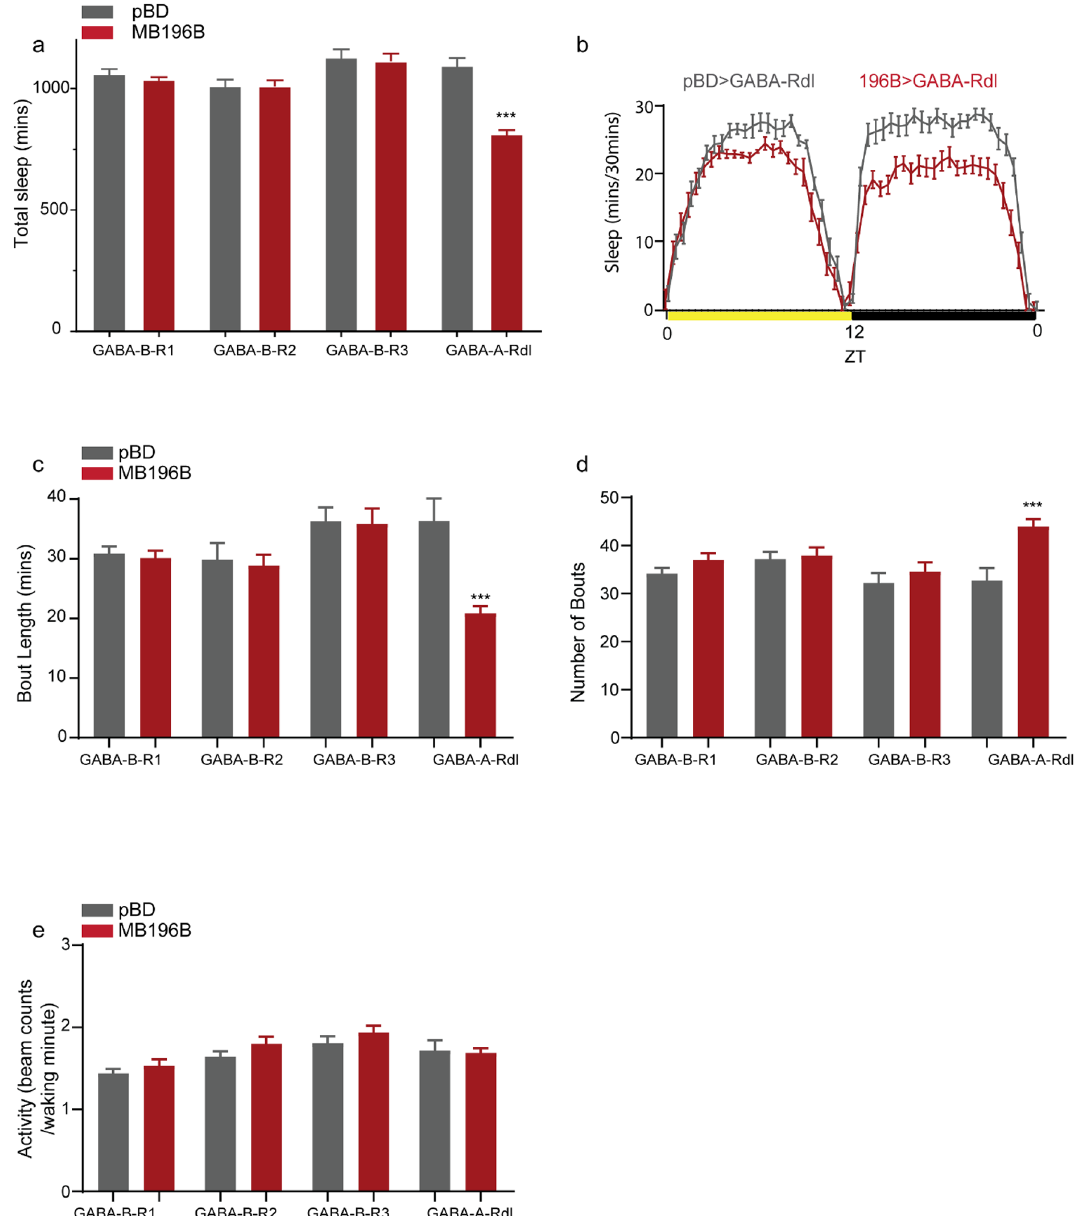
Figure 2. PAM-DAN mediated wakefulness is inhibited by GABA and GABA A Rdl receptor expression. RNAi lines targeting GABA A and GABA B receptors were expressed in PAM-DANs targeted by MB196B or control (empty split-GAL4/pBD) and sleep was measured using Drosophila Activity Monitoring system. Sleep data represents 2-day average after 2-days of 12 h light and 12 h. dark entrainment. ( a ) Total sleep or sleep duration over 24 h in flies expressing validated RNAi lines targeting one of the GABA B (R1, R2 and R3) or GABA A (Rdl-Resistance to dieldrin) receptor or subunits in wake-promoting PAM-DANs (MB196B: red) and enhancerless/empty-GAL4 (pBD: grey) in the same genetic background. Significant differences were detected between MB196B and pBD driver lines expressing UAS-RNAi targeting GABA A Rdl receptor. ( b ) Representative sleep profile of RNAi mediated depletion of ionotropic GABA A Rdl receptors in PAM MB196B (red) and empty/enhancerless-GAL4 control (grey). ZT indicates zeitgeber time where ZT 0: lights on and ZT 12: lights off. ( c , d ) Average bout length (minutes) and average number of bouts. Significant differences were detected between MB196B and pBD driver lines expressing UAS-RNAi targeting GABA A Rdl receptor. ( e ) Activity or average beam crossings/waking minute indicative of locomotor activity of all tested genotypes. No significant differences were detected. For each of the experimental groups we had 34–41 flies which represents 2 independent experimental trials. Number of flies for each genotype were: GABA B -R1 (MB196B: 37, pBD: 40), GABA B -R2 (MB196B: 39, pBD: 41), GABA B -R3 (MB196B: 35, pBD: 38), and GABA A - Rdl (MB196B: 34, pBD:36). In this and all subsequent figures data represents mean and SEM, * indicates p < 0.05, ** indicates p < 0.001 and *** indicates p < 0.0001. Statistical analysis was Mann–Whitney U-test post-hoc analysis between MB196B and control expressing the same UAS-RNAi lines for ( a ), ( c ), ( d ), and ( e